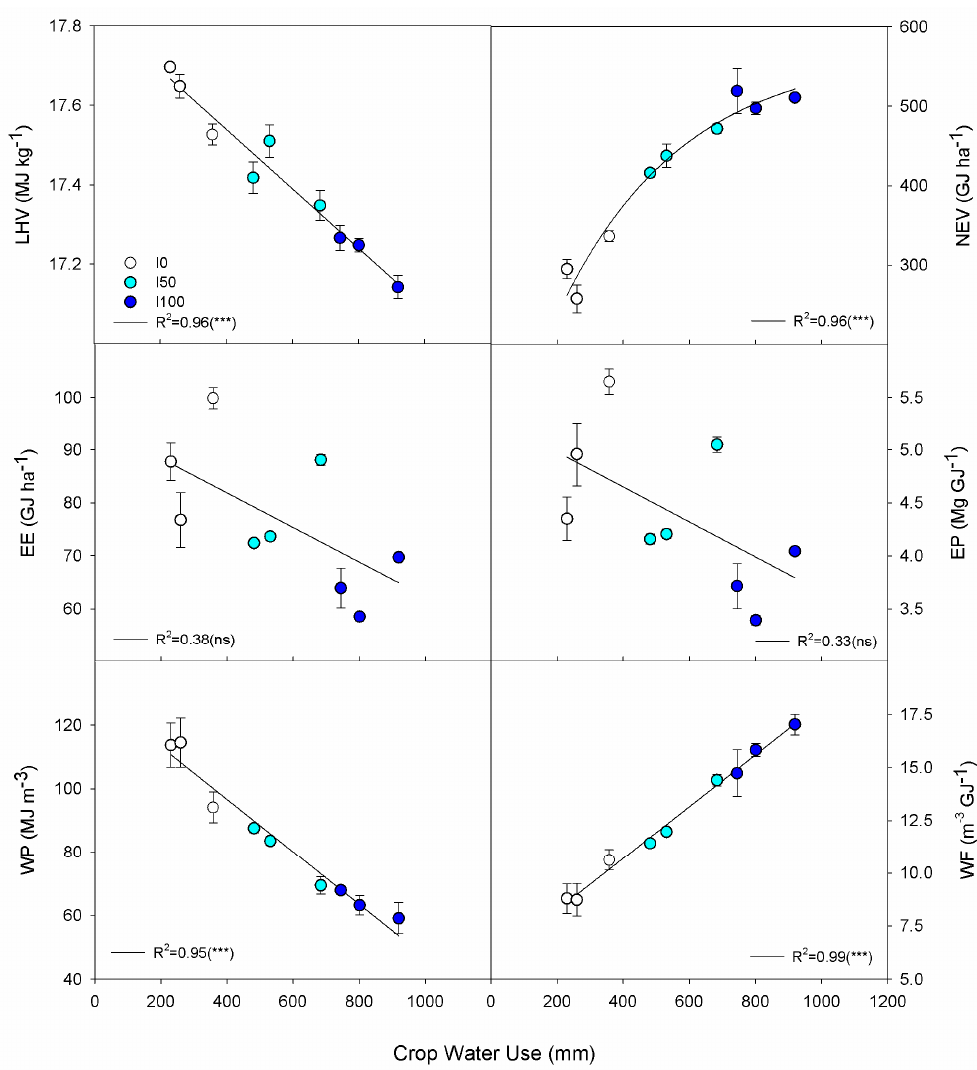
Figure 4. Relationships between crop water use (mm) and energy indicators (lower heating value—LHV, net energy value—NEV, energy e ffi ciency—EE, energy productivity—EP) and water indicators (water productivity—WP, water footprint—WF) of Saccharum under changing irrigation and growing season. Regression significance indicated by *** at p ≤ 0.001, or (ns) not significant.